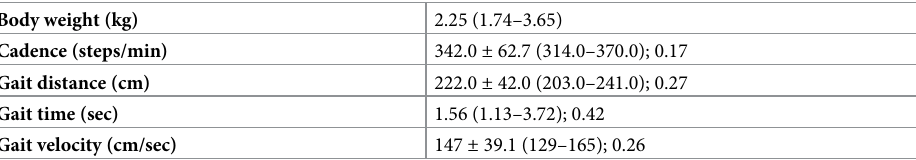
Table 1. Experiment 1: Normal duck gait